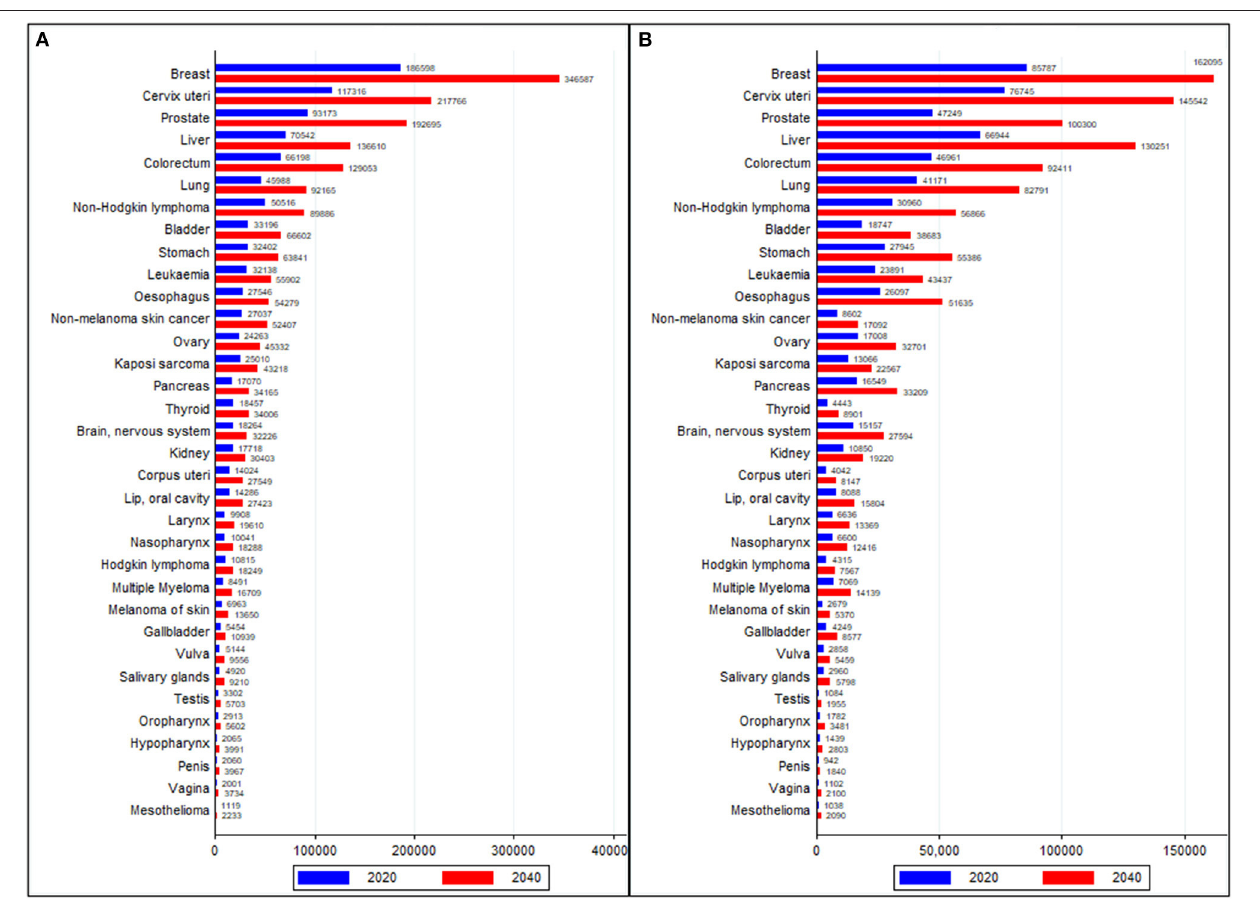
FIGURE 6 | Comparison of cancer burden of all cancer groups in 2020 and forecasted values in 2040 (A) Incidence and (B) Deaths. Data source: GLOBOCAN 2020 (International Agency for Research on Cancer).